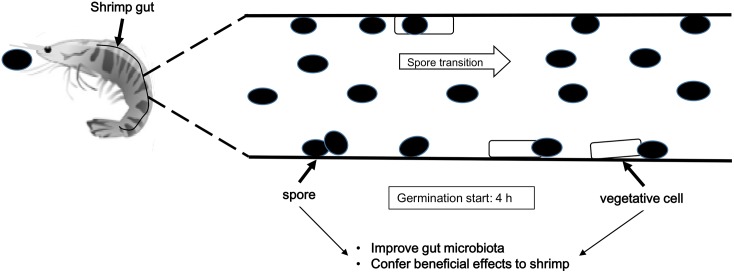
Model for fate of SH6 spores in shrimp gut.After feeding SH6 spores to white-leg shrimp, majority of the spores transit quickly through the shrimp gut. However, minority of spores adhere and accumulate onto the intestinal epithelium, then germinate into vegetative cells after 4 h feeding. The colonized spores and vegetative cells of SH6 strain play a key role in improving gut microbiota and conferring multiple beneficial effects to the host.